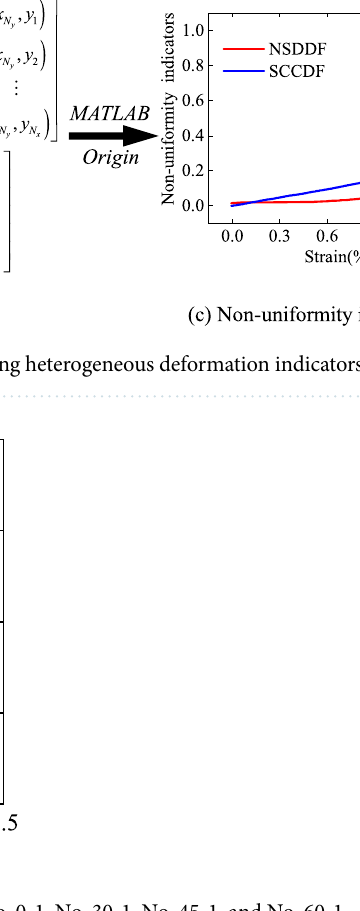
Figure 5. Experimental stress–strain curves: specimen No. 0-1, No. 30-1, No. 45-1, and No.